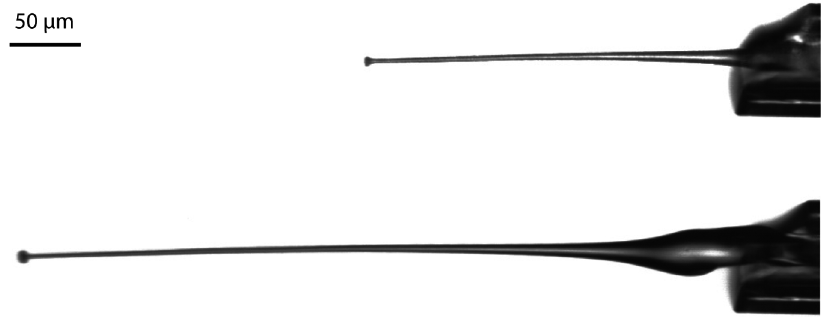
FIG. 2. Images of a supersonic microjet generated in a 50 - (cid:1) m capillary tube. The capillary is visible on the right side; the jet tip is shown on the left. The jet travels from right to left with a speed of 490 m = s . Time between images is 500 ns.